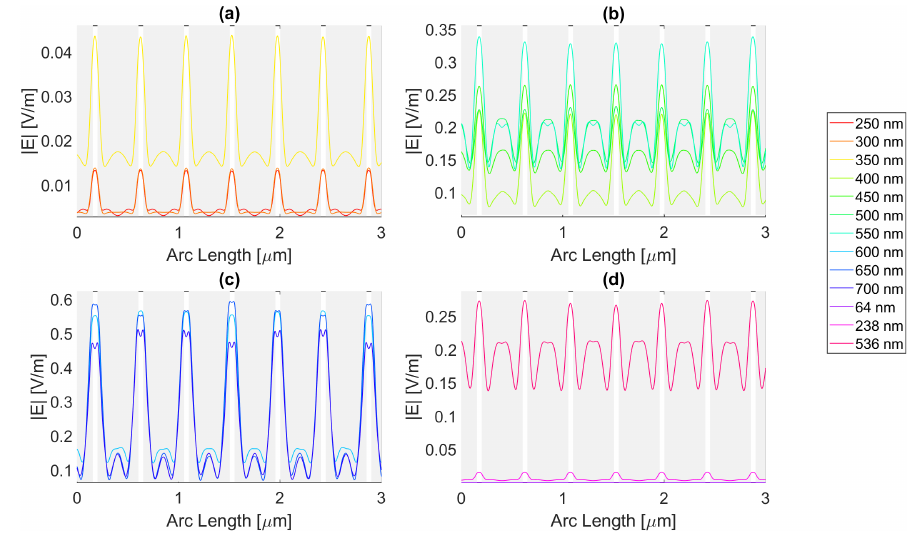
Figure 10. Electric field for gold 50-nm-thick rectangular nanostructure—Probe 1. As with silver and gold, in Figure 11, copper shows two peaks for wavelengths between 600 and 700 nm at the slit. Since the design is thicker, there is more antenna side area, which results in more reflected radiation.